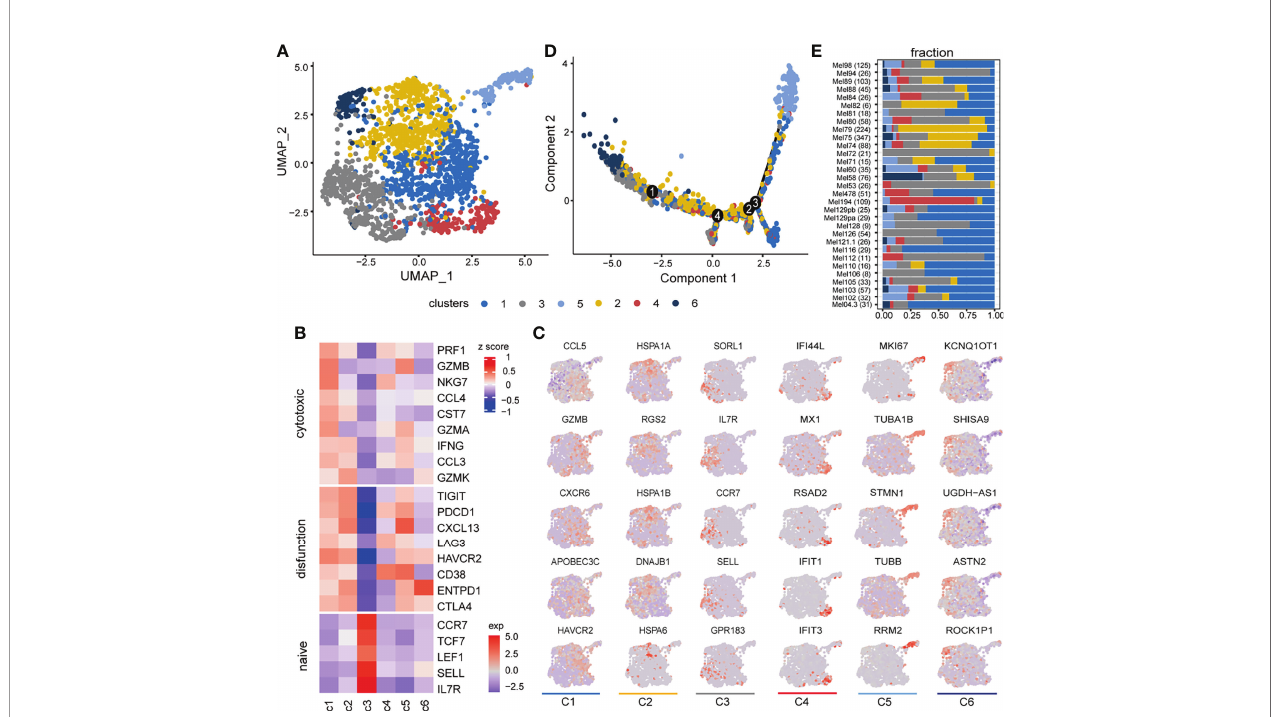
FIGURE 2 | Inferred cell states of CD8+ T cells from SKCM patients. (A) UMAP plot of 1,759 CD8+ T cells (samples n = 31), including 6 clusters annotated by different colors. (B) Heatmap showing expression levels of canonical CD8+ T-cell function-associated markers in each CD8+ T cluster. (C) UMAP feature plot representation of selected cluster-speci fi c differential markers within individual CD8+ T-cell clusters. Each column corresponds to six clusters in order. (D) The trajectory distribution of CD8+ T-cell clusters. (E) The composition of CD8+ T-cell clusters in each sample, where the number of cells contained in the sample is shown in parentheses on each